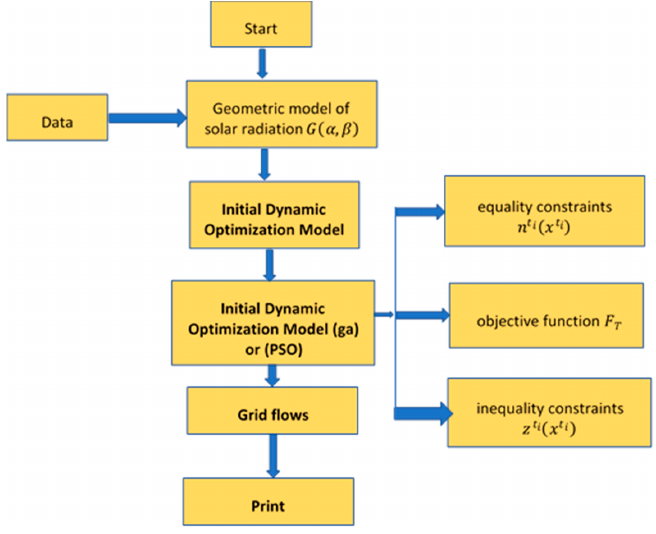
Figure 3. Optimization computational algorithm.